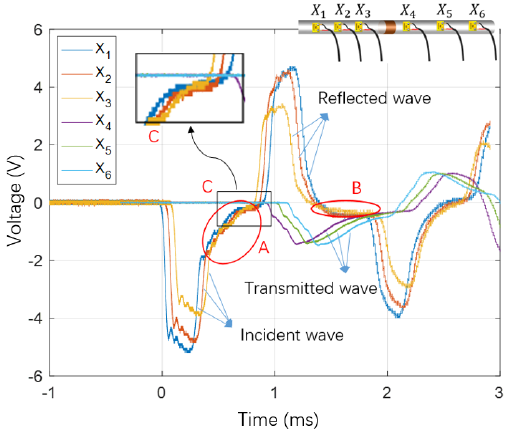
Figure 4. The voltage signal measured by C2 (v = 18 m/s).